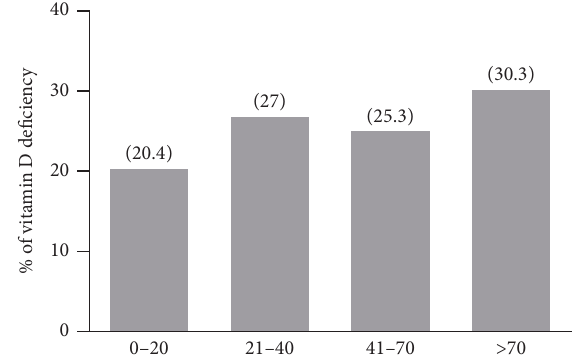
Figure 1: Percentage of vitamin D deficiency according to age group. Values lower than 20 ng/mL were considered as deficiency. Numbers in parenthesis show the exact percentage for each age group. A significant correlation was found between age and vitamin D deficiency ( 𝑝 <